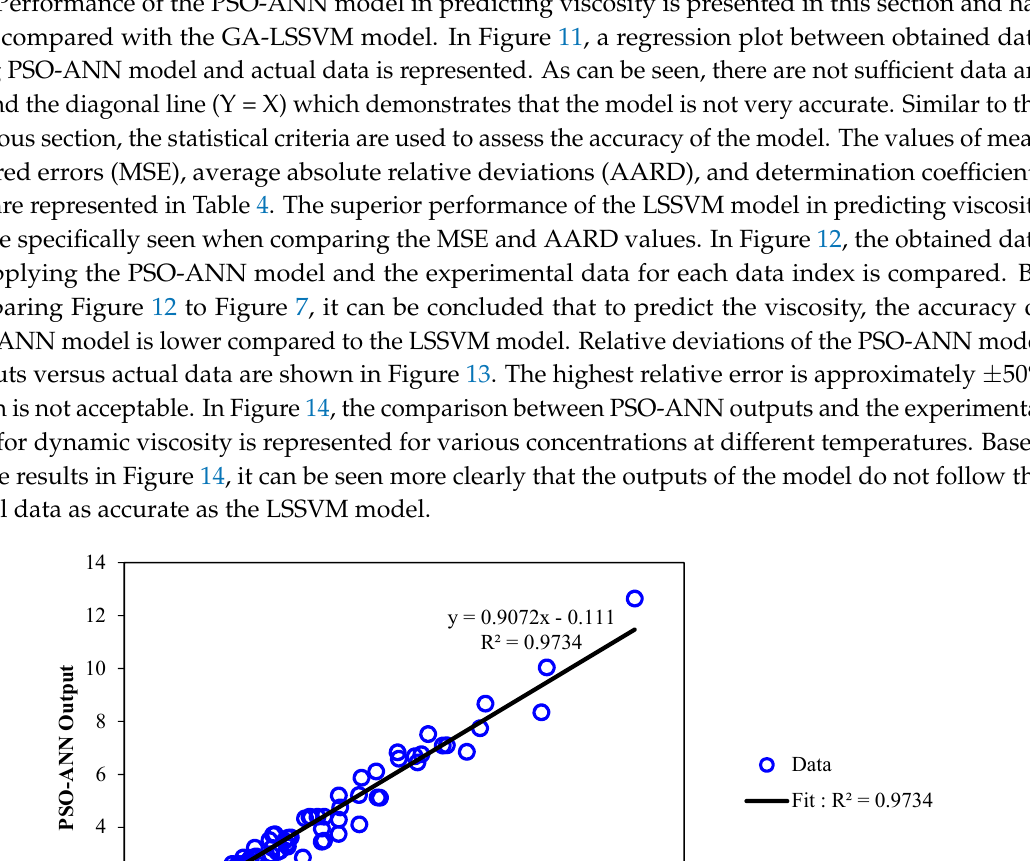
Figure 11. Regression plot of the proposed PSO-ANN model versus actual viscosity of Fe 2 O 3 /ethylene glycol ‐ water nanofluid.